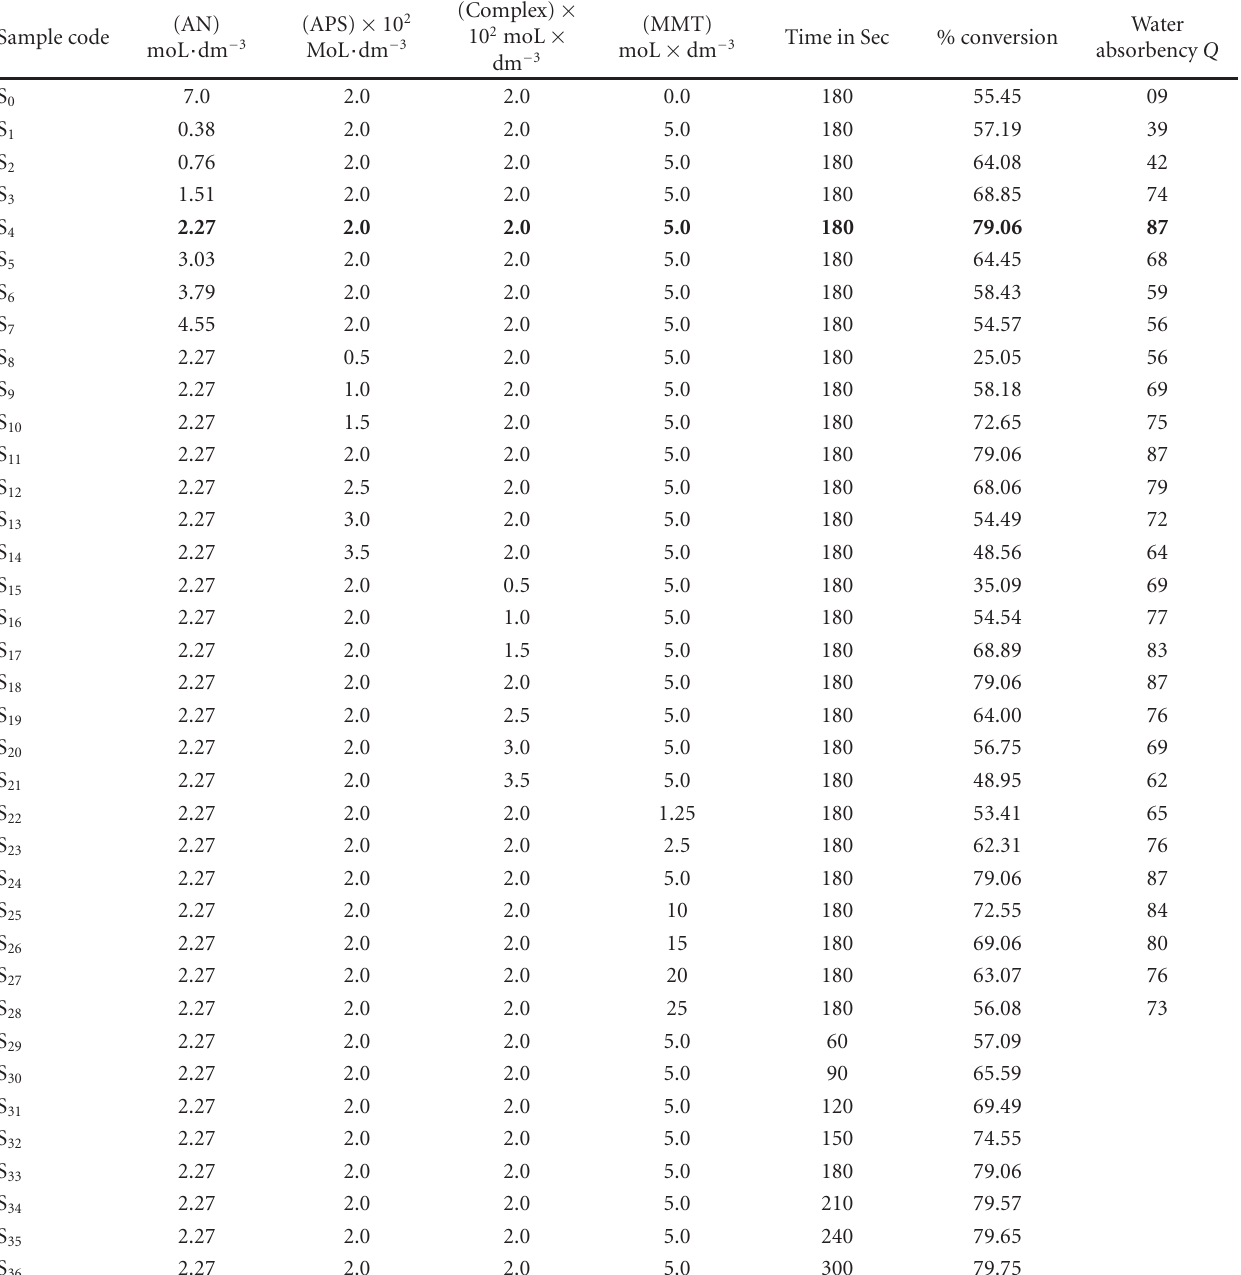
Table 1: E ff ect of variation of concentration of AN, APS, Co(III) complex, MMT, and time on the % of conversion and water absorbency. Sample